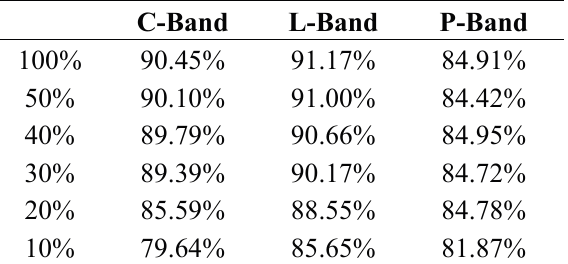
Table 10. Overall Accuracies of classification with reduced